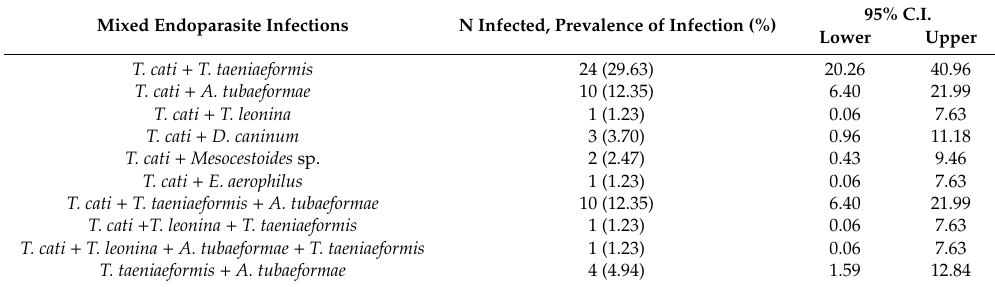
Table 2. Prevalence (%) of mixed endoparasite infections in